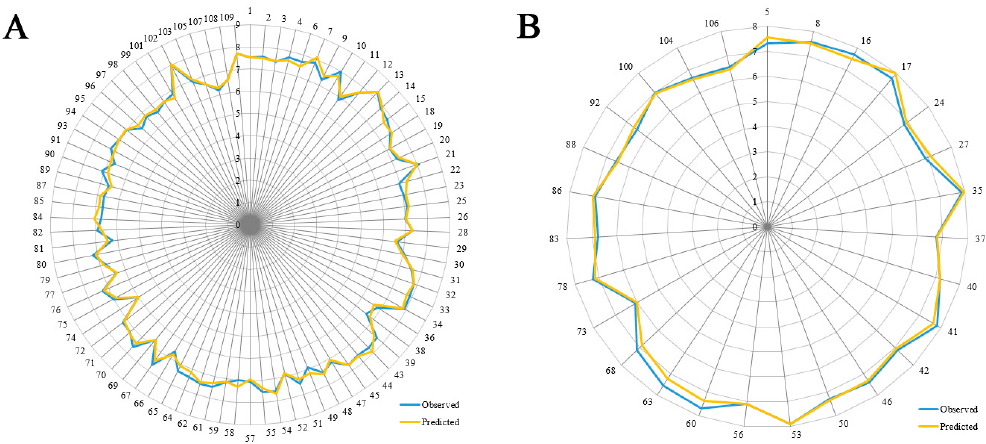
Figure 4. The radar plots of the predicted versus the experimental pIC 50 values using the training ( A ) and the test ( B ) compounds from the final optimal CoMSIA model.